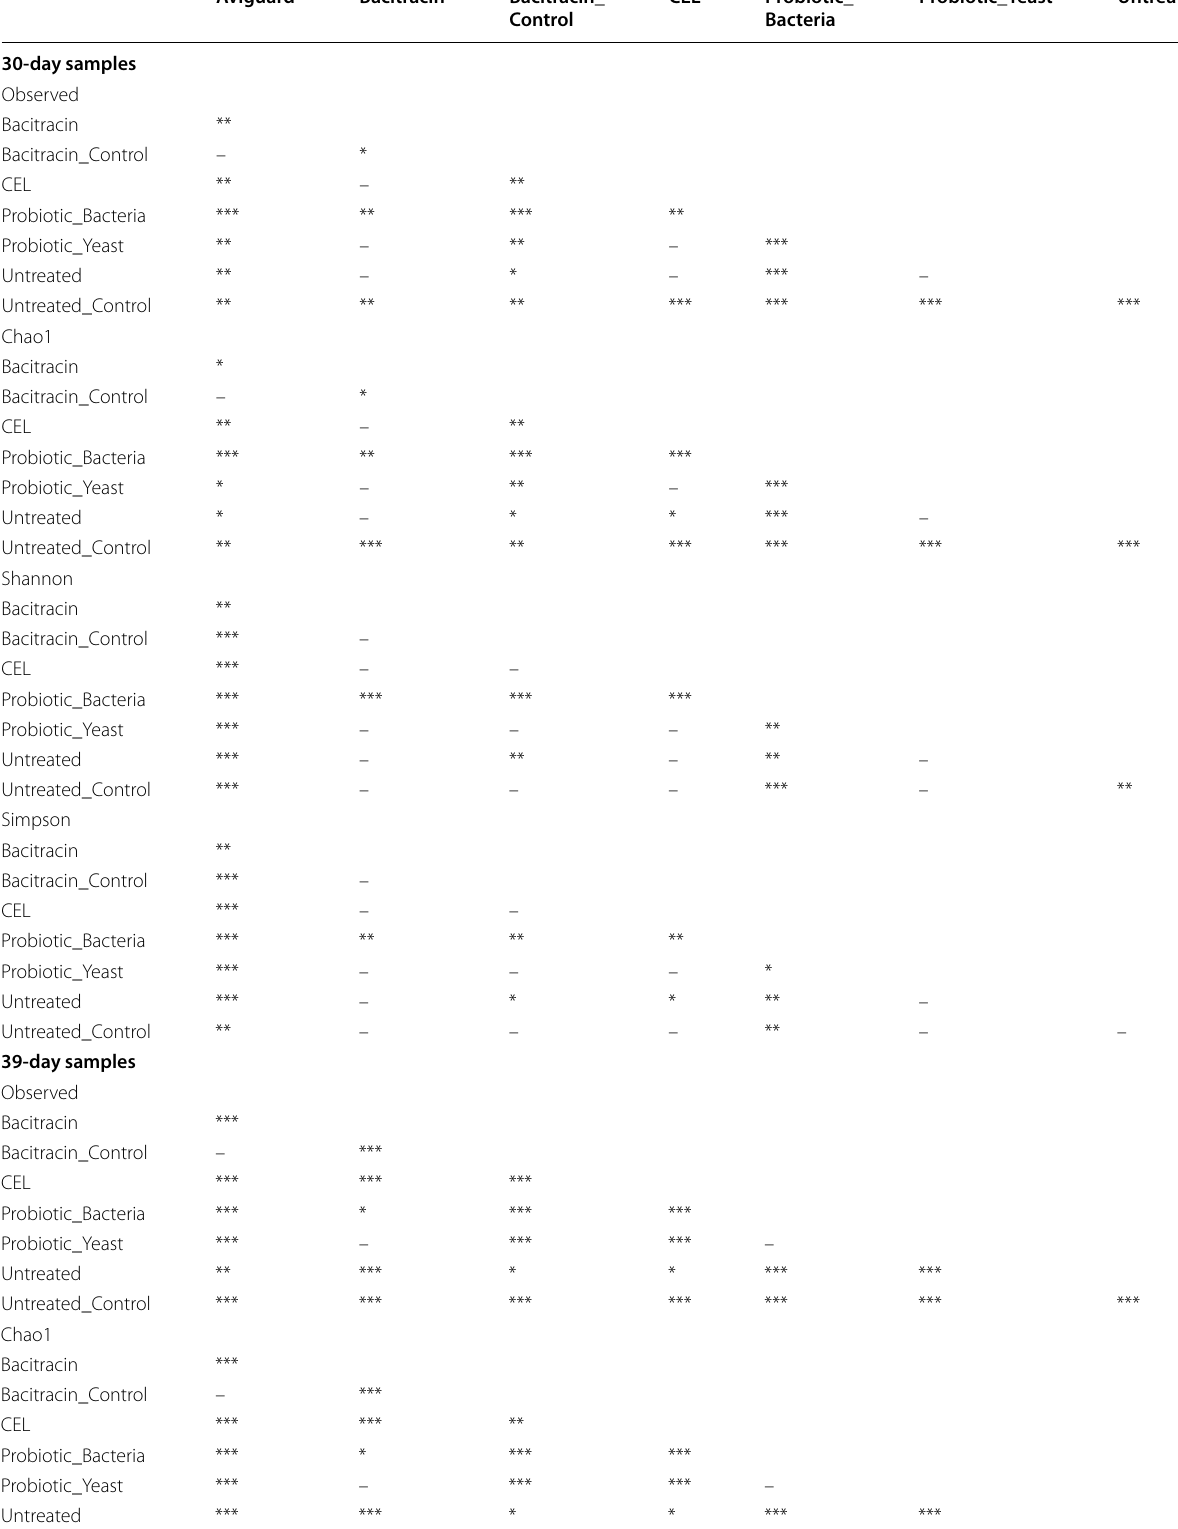
Table 1 Significant differences in alpha diversity indices in pairwise comparisons between treatments Aviguard Bacitracin Bacitracin_ CEL Probiotic_ Probiotic_Yeast Control Bacteria